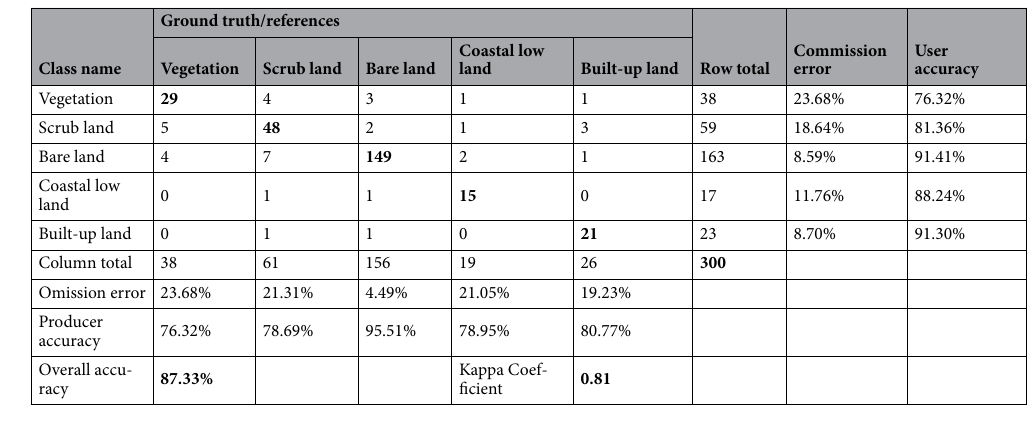
Table 5. Accuracy assessment and kappa coefficient for the year of 1990. The [bold] value is necessary to identify the accuracy assessment and kappa coefficient.